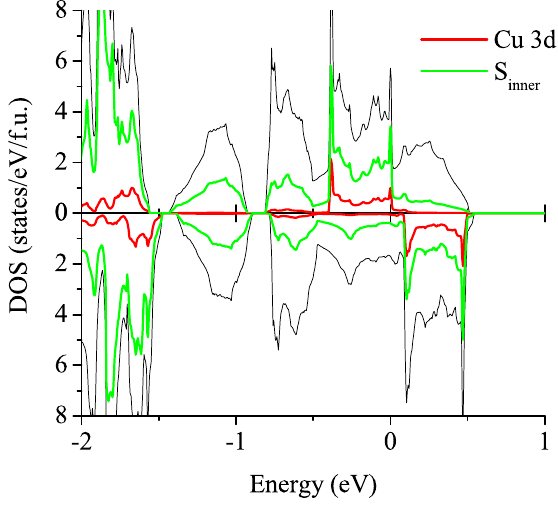
with partial densities of 2 ), inner